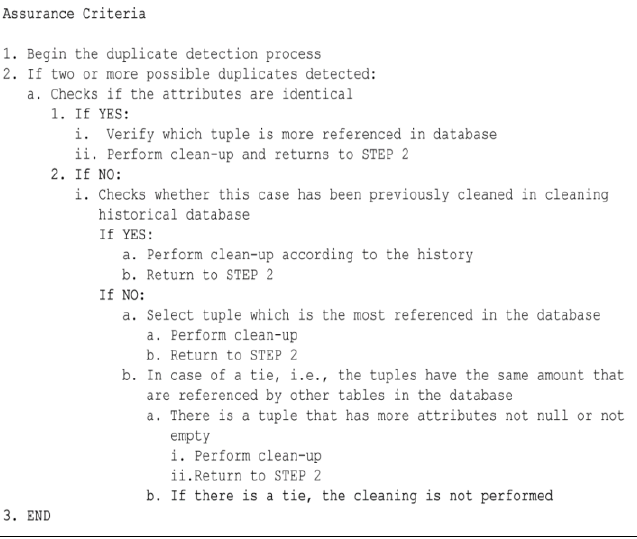
Figure 3: Assurance criteria algorithm for automated duplicates correction.